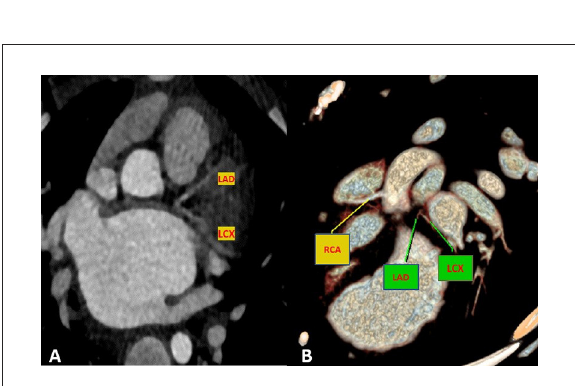
FIGURE3 Maximum intensity projection (A) and volume rendered (B) CT images demonstrate an absence of the LM artery